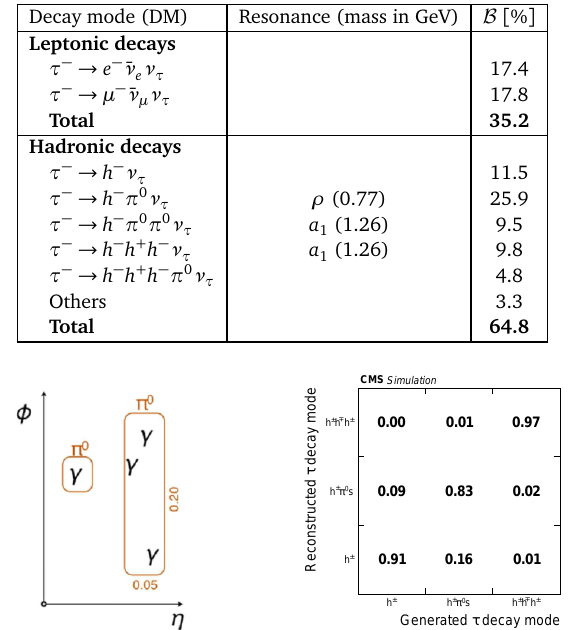
Table 1: Decay modes of the τ lepton and their branching fractions [ 1 ] .